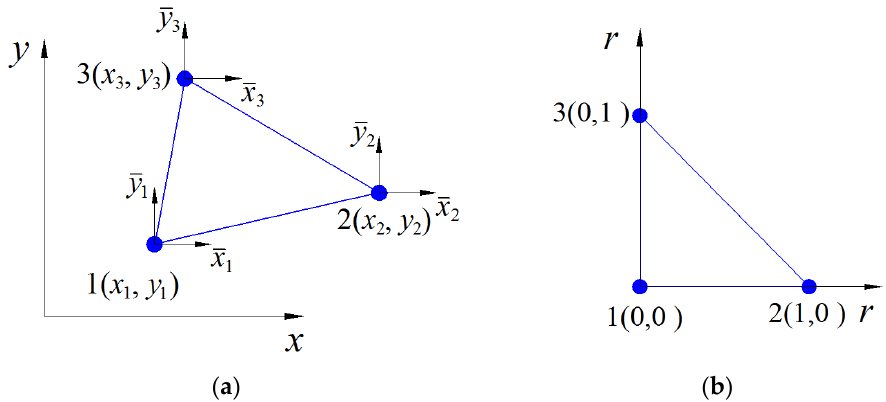
Figure 1. The employed coordinate system in this extrinsic EFEM: ( a ) the global coordinate and relative coordinate system for a triangular element; ( b ) the natural coordinate system for an isoparameter triangular element.